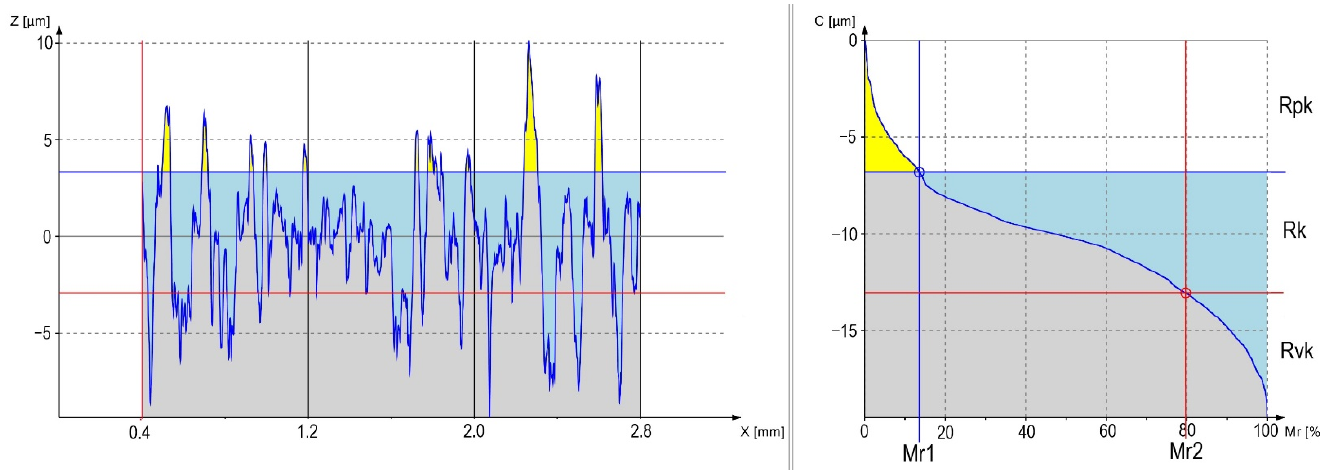
Figure 3. Material ratio curve in the profile of sample S56.